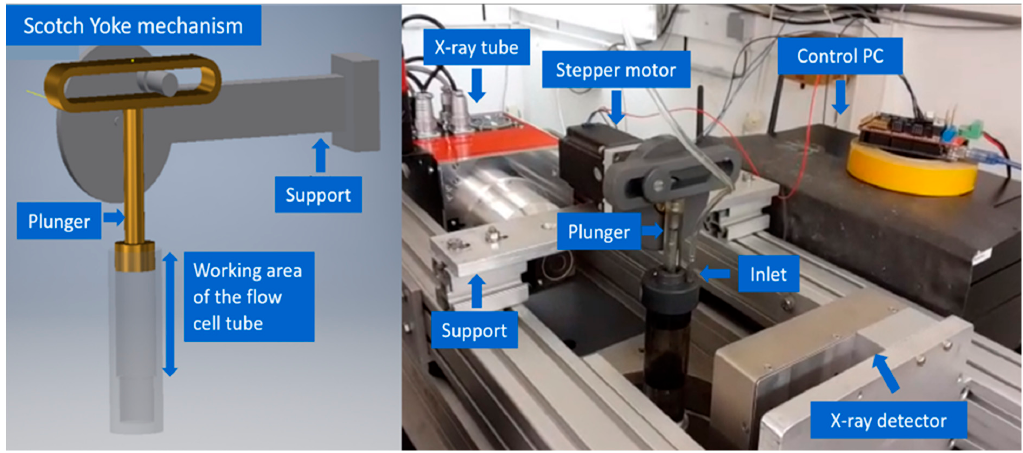
Figure 2. Picture and schematic drawing of the flow cell (Front view) with attached flow channels.